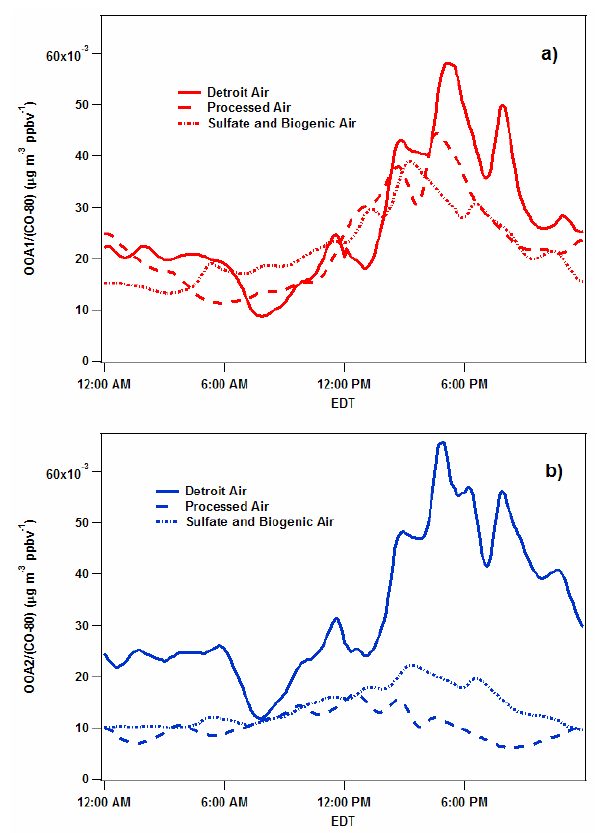
Figure 9. Diurnal profiles of CO-normalized AMS PMF factors during selected episodes of the campaign: OOA1-upper frame, OO2-lower frame